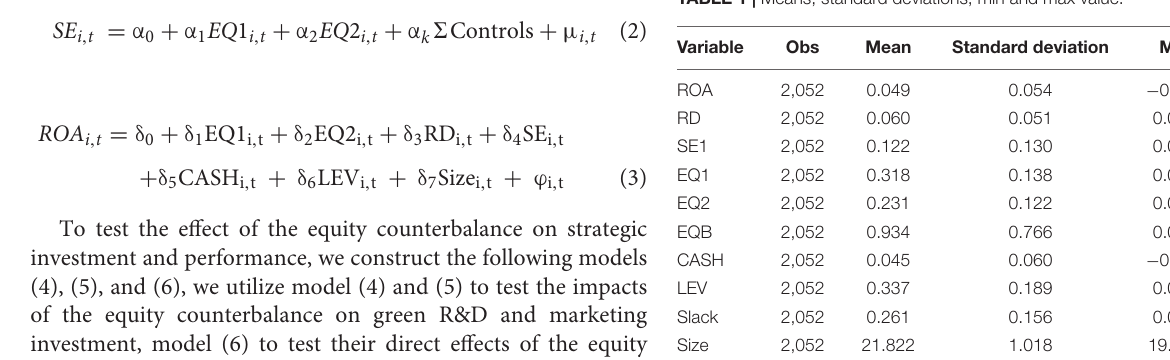
TABLE 1 | Means, standard deviations, min and max